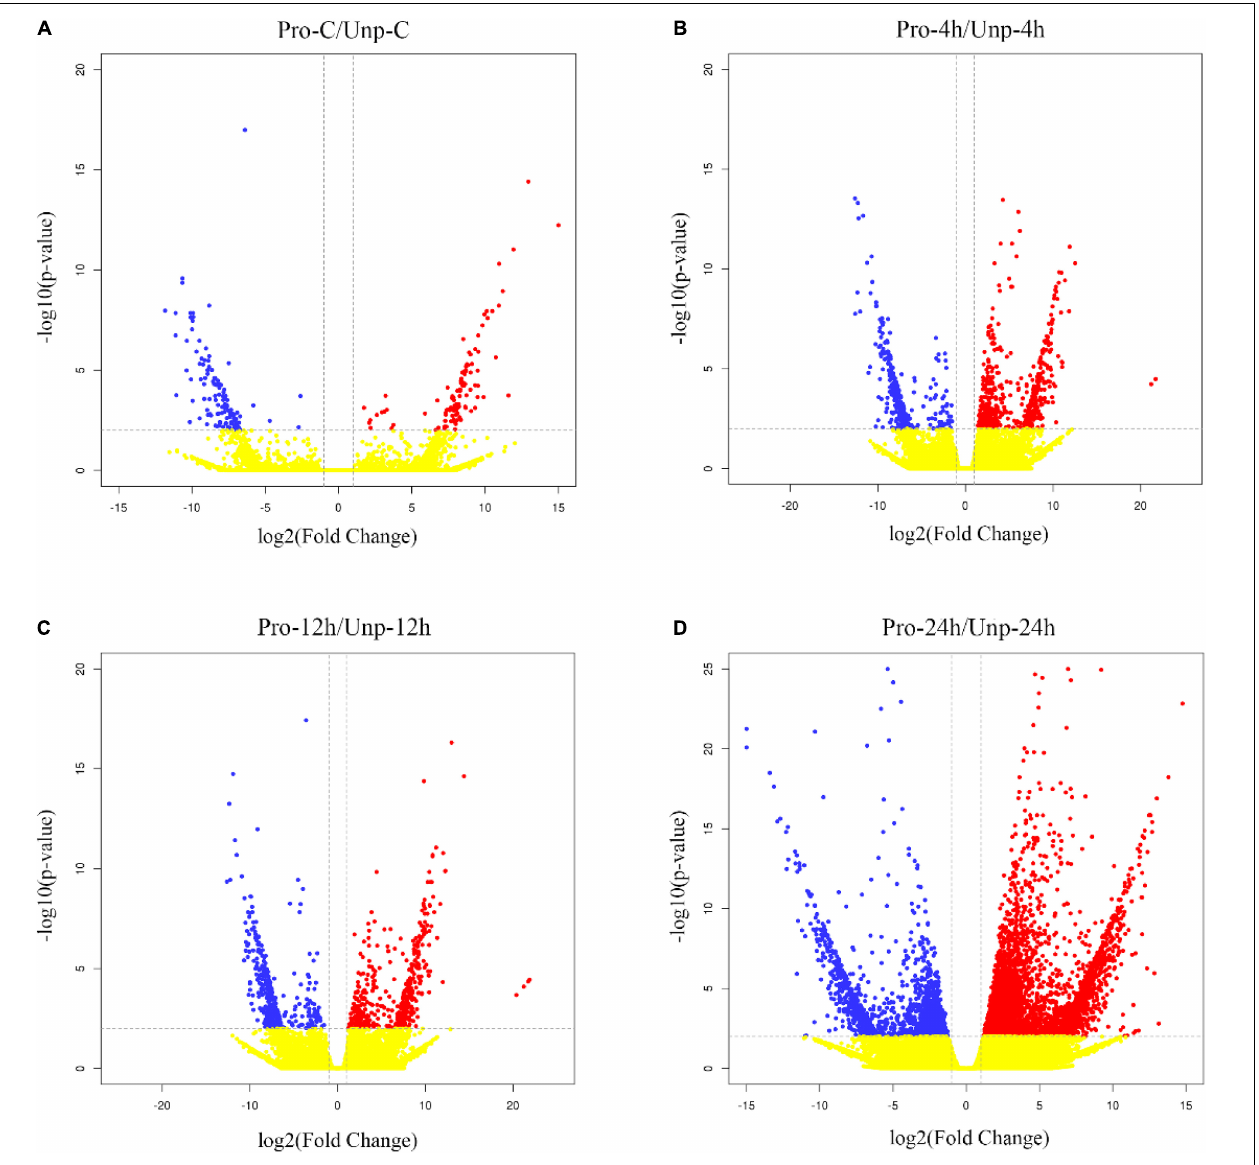
FIGURE 1 | (A) Volcano plot of DEGs distribution trends between Pro-C and Unp-C. Each dot stands for a gene. Red dots indicate up-regulated DEGs; blue dots are down-regulated DEGs; and yellow dots stand for the genes with no difference. (B) Volcano Plot of DEGs distribution trends between Pro-4h and Unp-4h. (C) Volcano Plot of DEGs distribution trends between Pro-12h and Unp-12h. (D) Volcano Plot of DEGs distribution trends between Pro-24h and Unp-24h.